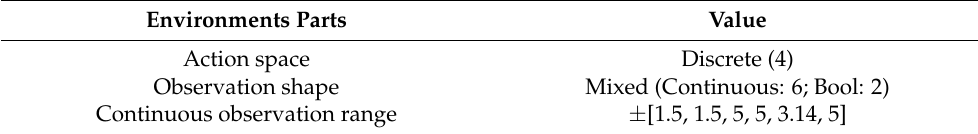
Figure 5. Example of the lunar lander problem environment. Table 4. Lunar lander problem environment. Table 4. Lunar lander problem